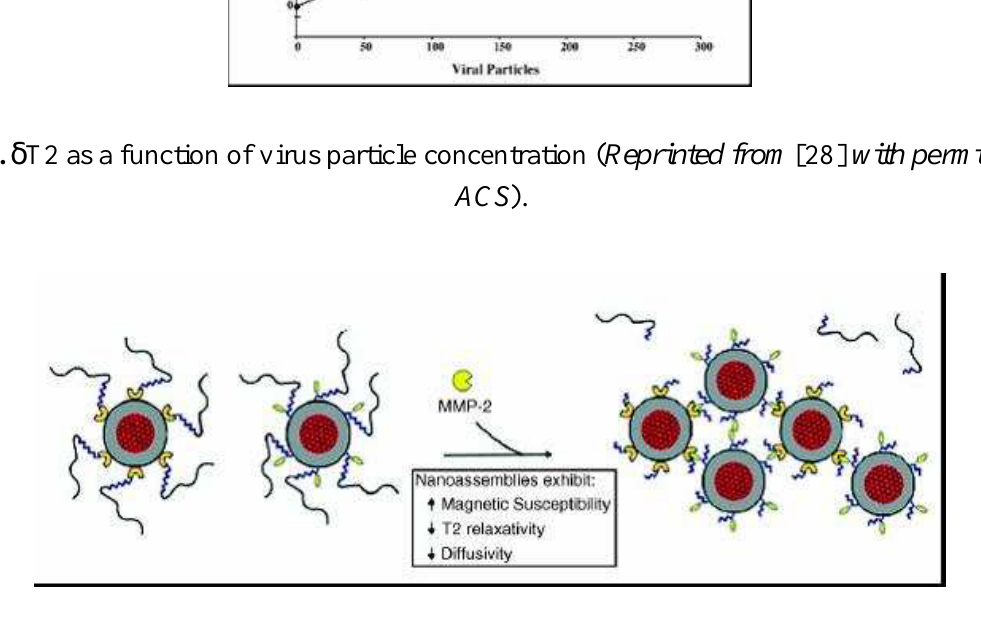
Figure 14. Proteolytic activation. In the presence of MMP-2, PEG molecules are cleaved allowing self assembly of nanoparticles. ( Reprinted from [29] with permission from Wiley-VCH